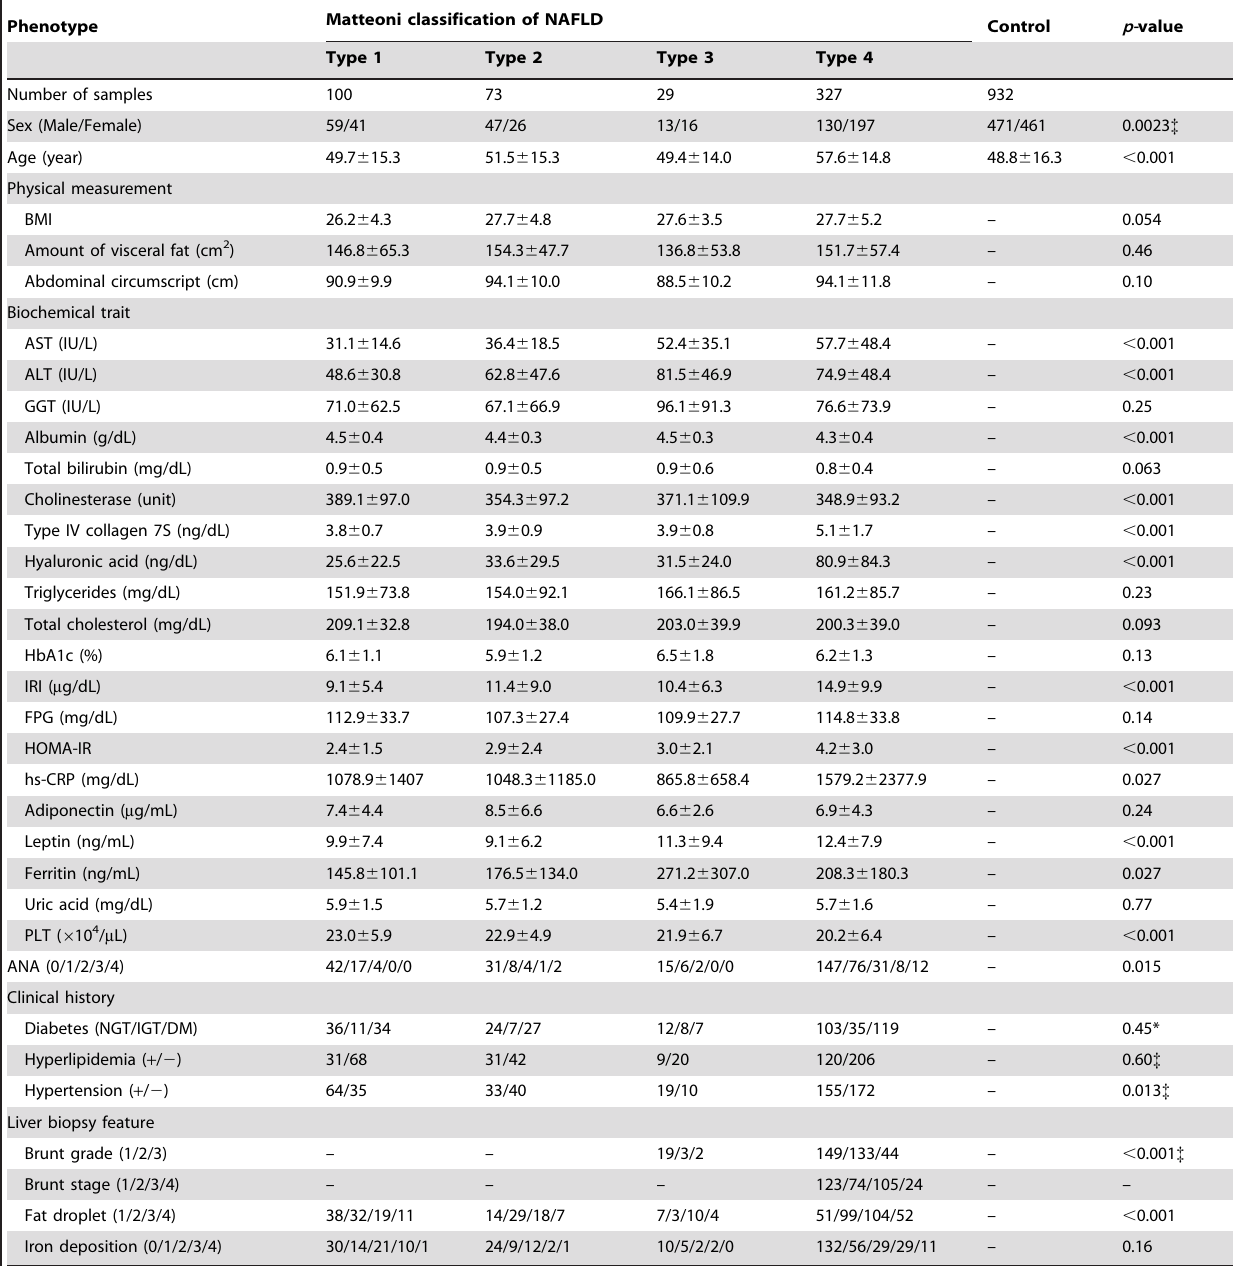
Table 1. Clinical characteristics according to the histological